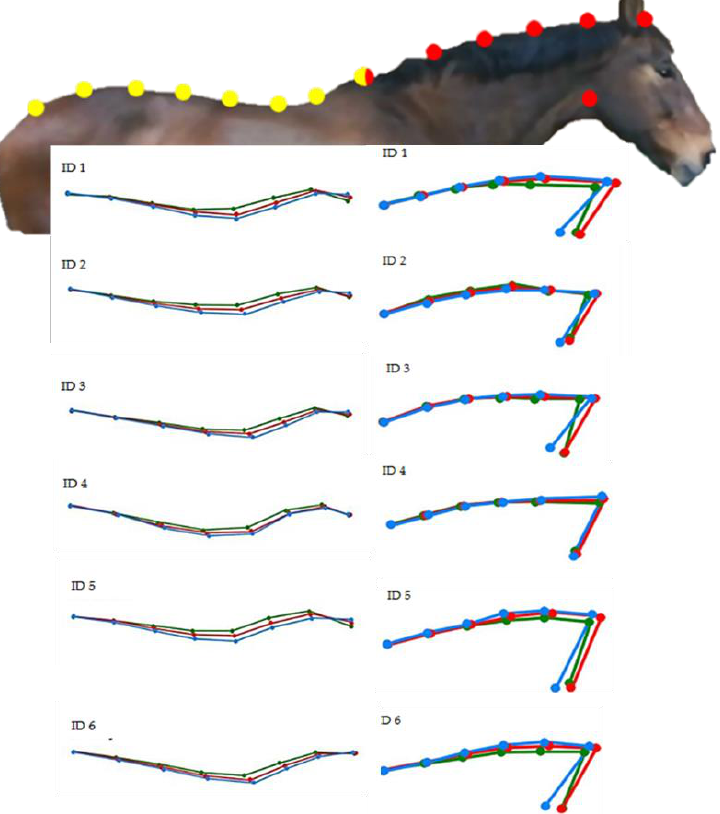
Figure 9. Mean individual shape variations in back and neck postures according to the three different feeding positions: red, on the ground — control position (CP); green, neck held 15 ± 3° below withers height with low hay net position (LP); and blue, neck held 15 ± 3° above withers height with high hay net position (HP).